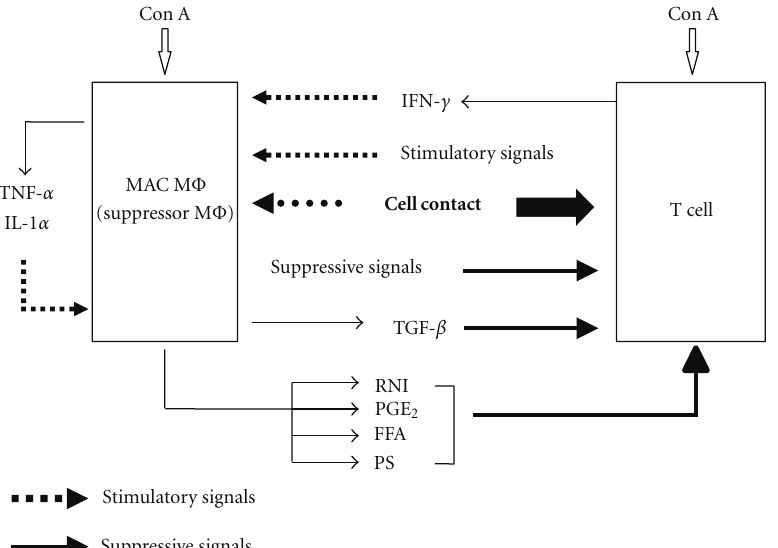
Figure 2: Mechanisms of intercellular transduction of immunosuppressive signals from MAC-induced suppressor macrophages to target T